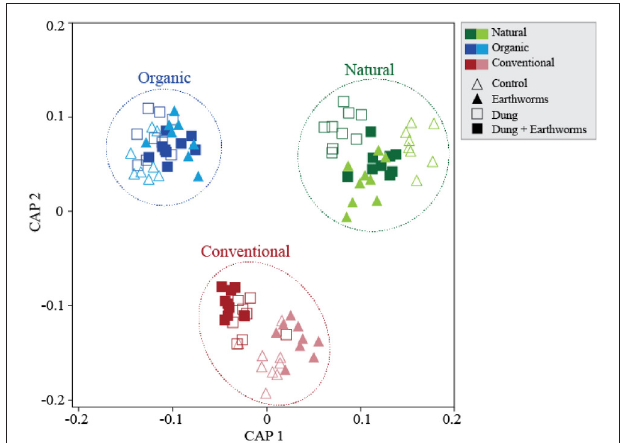
FIGURE 2 | Soil bacterial community structures in response to dung and earthworm treatments across soil management regimes. Canonical Analyses of Principal Coordinates based on constrained ordination by soil management * treatment . Canonical correlation (informs on the association strength between the data and the hypothesis of differences among treatments): First axis δ 2 = 0.97, Second axis δ 2 = 0.96. TraceQ_m’HQ_m statistic (sum of canonical eigenvalues) tests the null hypothesis for no significant differences among treatments and represents an overall test to reject the null hypothesis: 7.78*** (*** P < 0.001).